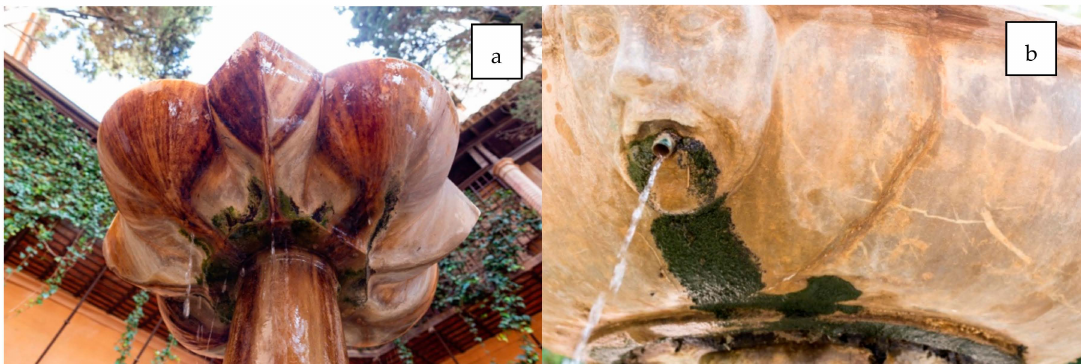
Figure 1. ( a ) Two di ff erent phycofilms on the Fuente del Patio de la Reja at the Nasrid Palaces. ( b )